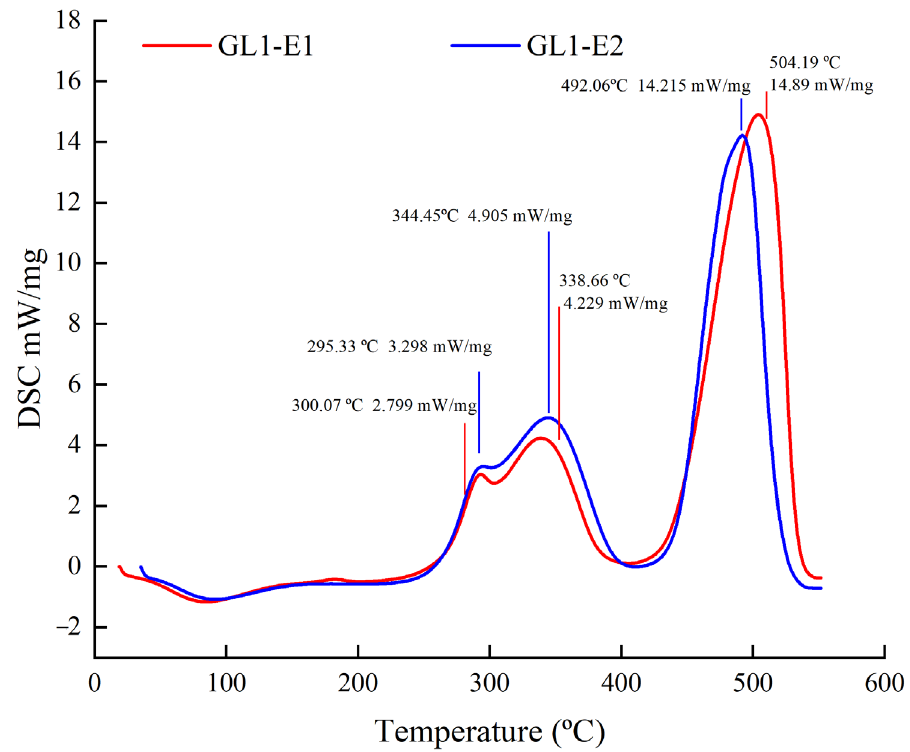
Figure 5. The DSC curves of GL1-E1 and GL1-E2.